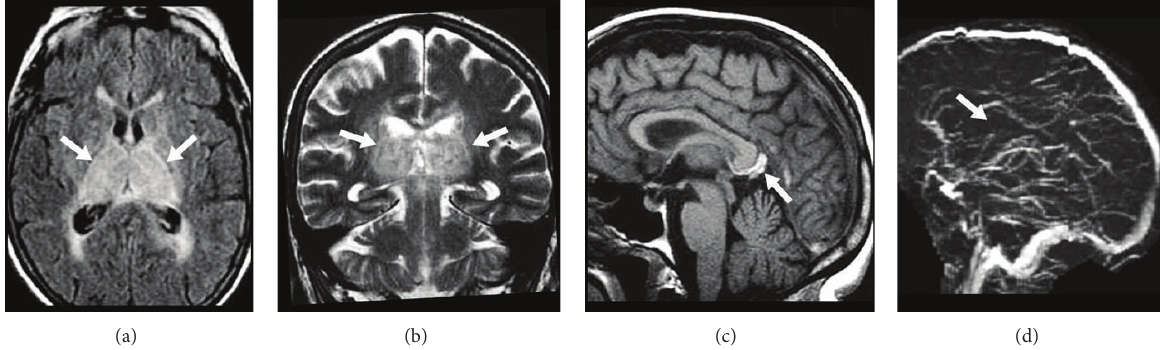
Figure 7: Bilateral thalamic vasogenic edema seen as hyperintensity on both axial FLAIR (a) and coronal T2-weighted (b) imaging due to venous thrombosis of the deep cerebral venous system. The venous thrombosis of the vein of Galen is seen as hyperintensity on sagittal unenhanced T1-weighted imaging (c), and lack of flow in the deep cerebral venous system is seen on MR venography